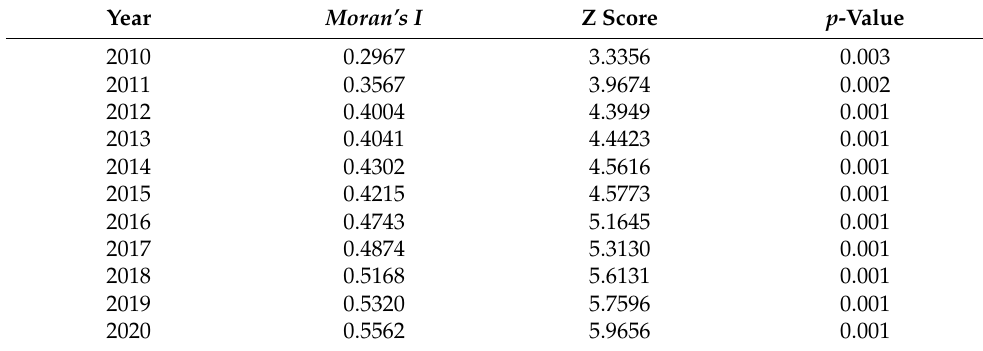
Table 3. Changes in global Moran’s I index of the BPSL in the YRDR,